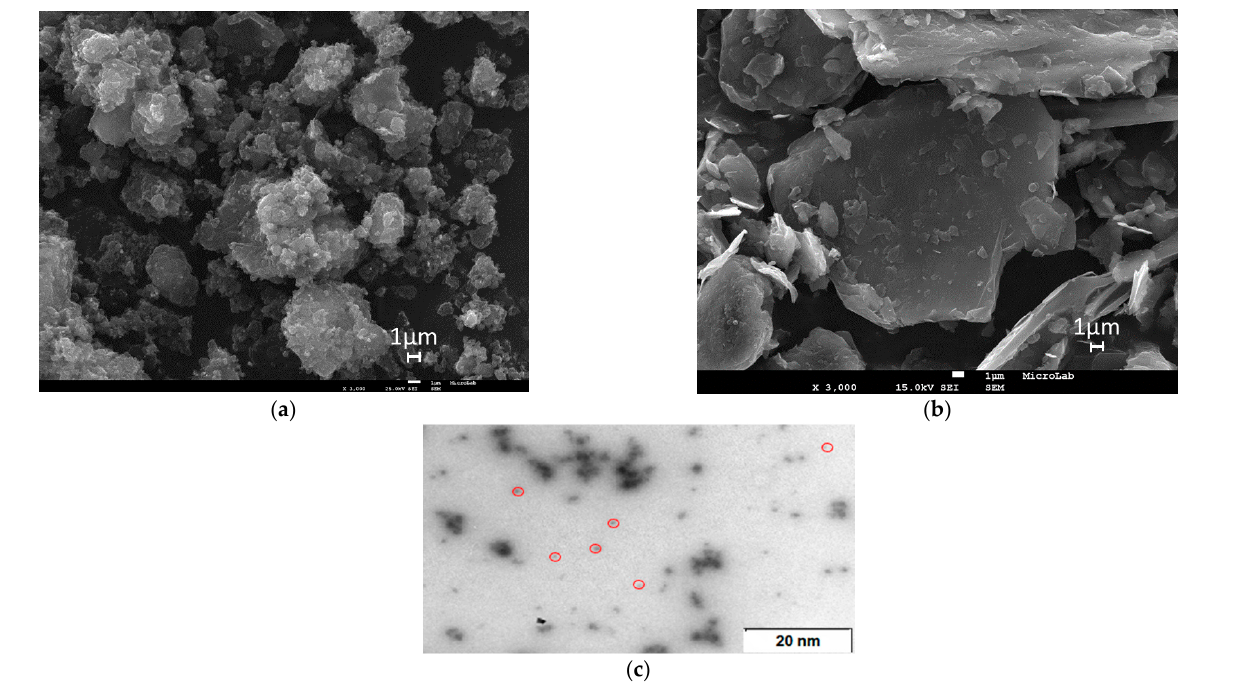
Figure 2. SEM, TEM images and EDS. ( a ) SEM image of Norit; ( b ) SEM image of graphene; ( c ) TEM image of Re NPs on a sheet of graphene (red circles highlight the Re NPs).